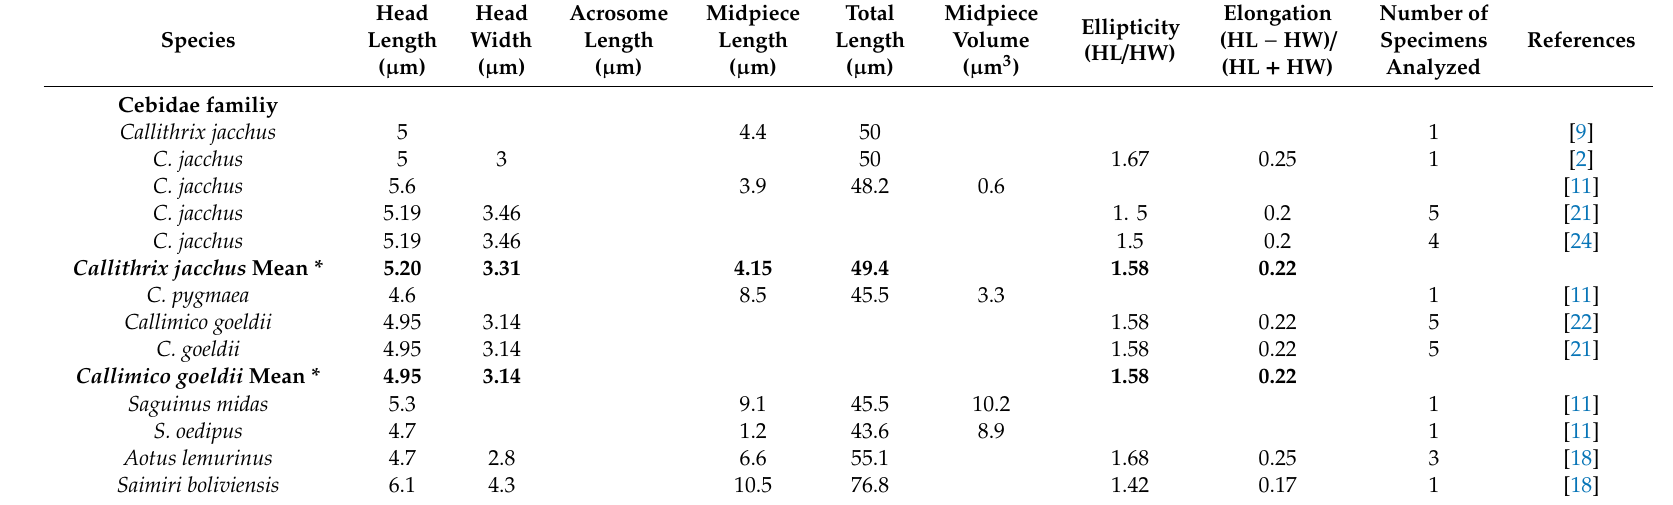
Table 2. Morphometric data on spermatozoa of neotropical primates collected from the